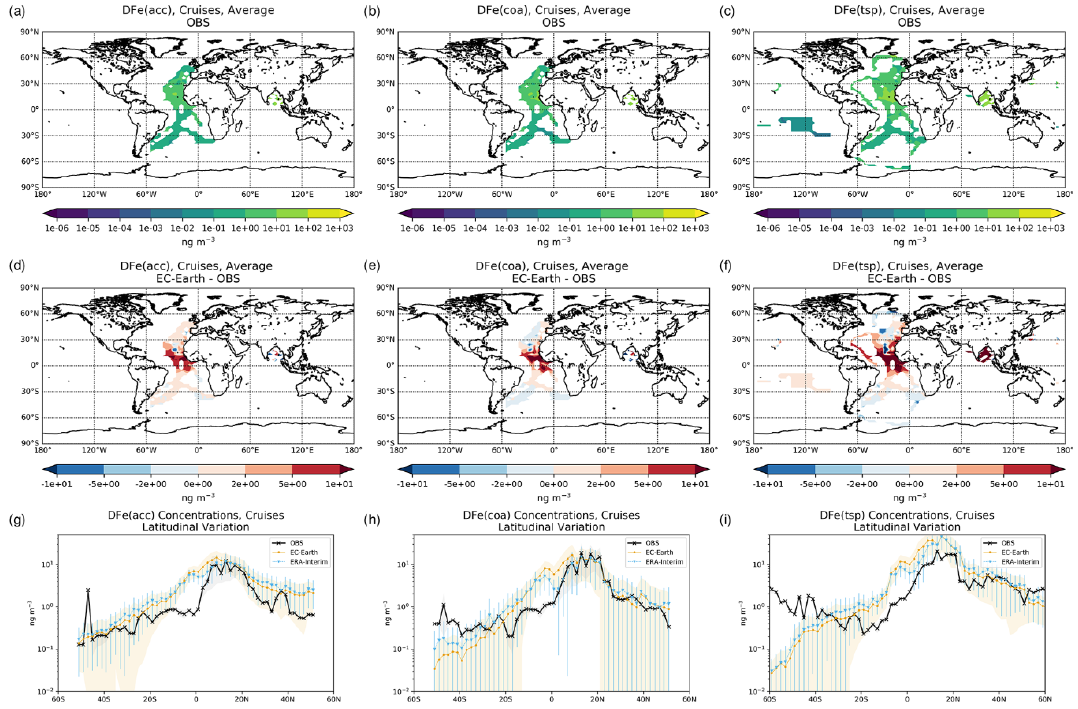
Figure 10. Observed (averaged for each model’s grid-cell) dissolved iron (DFe) concentrations (ngm − 3 ) of (a) accumulation aerosols, (b) coarse aerosols, and (c) total suspended particles (tsp). The respective absolute differences to the ERA-Interim simulation (d, e, f) and the comparison to observations (black line with crosses) in latitudinal order (g, e, f) with the EC-Earth (orange line with circles) and ERA-Interim (light blue line with triangles) simulations; the grey-shaded areas correspond to the standard deviation of the observations and the color-coded shaded areas/error bars correspond to the model’s standard error of the multi-annual mean for the individual observational